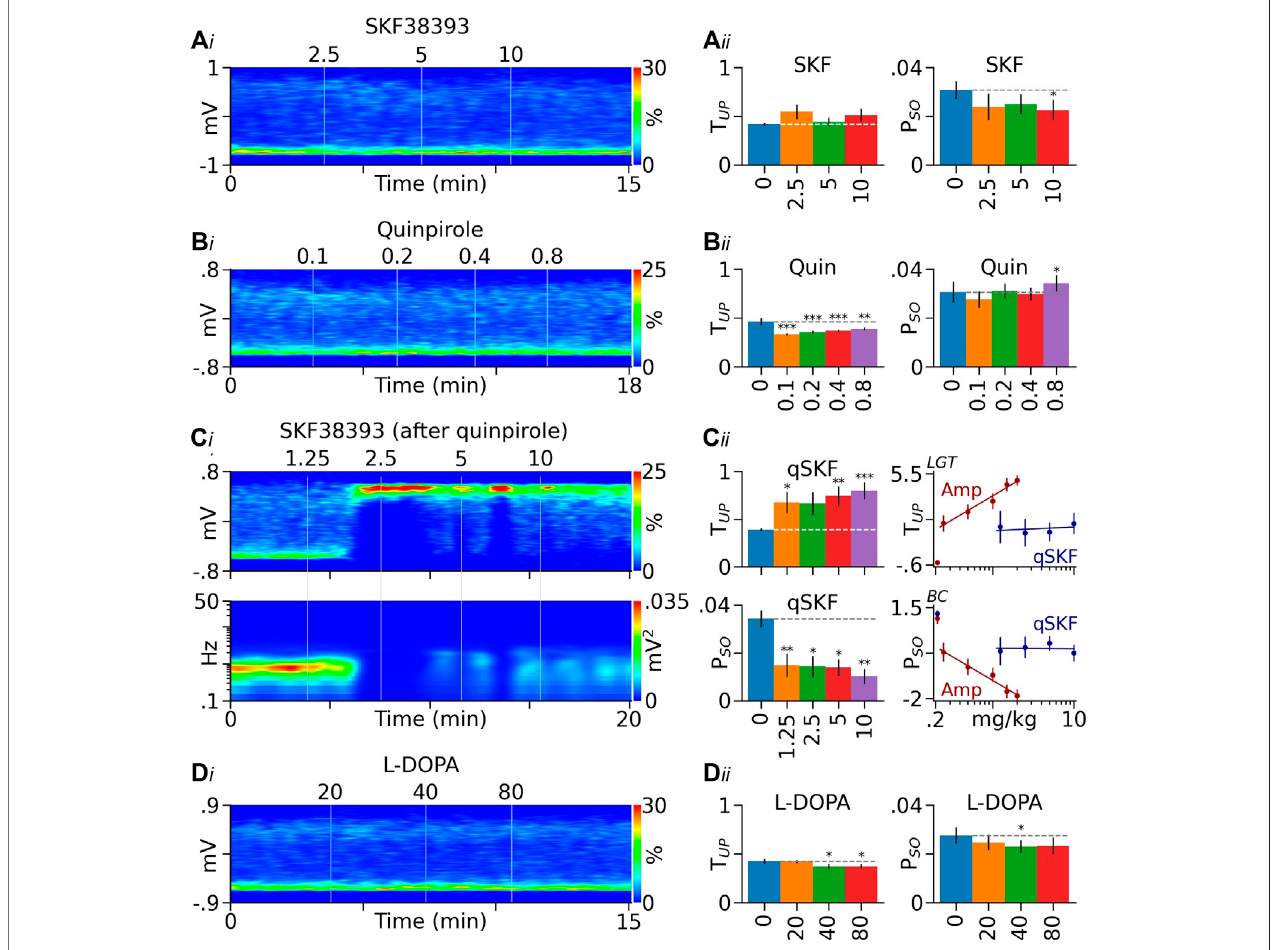
FIGURE 4 | Effects of DA receptor agonists and L-DOPA on PFC Up state. (Ai) Heatmap from a typical rat showing the lack of a signi fi cant effect of the D1-like receptor agonist SKF38393 (SKF) on PFC LFP distribution. (Aii) Summary graphs showing that SKF38393 produced no signi fi cant effect on T UP (left) and induced a smalldecrease in P SO (right). (Bi) Heatmap from another rat showing thatthe D2-like receptor agonist quinpirole (Quin) slightly shifted LFPs toward the Down state. (Bii) Summary graphs showing that thedecrease in T UP induced byquinpirole wassigni fi cant (left). Quinpirole also induced asmall increase in P SO (right). (Ci) Heatmap from a quinpirole-pretreated rat (0.8 mg/kg) showing that SKF38393 (qSKF) promoted the Up state (top) and suppressed the slow oscillation (bottom). (Cii) Summary graphs showing that in quinpirole-pretreated rats, SKF38393 signi fi cantly increased T UP and decreased P SO (left). Its dose-response curves are signi fi cantly right -shifted,however,relativetothoseof D -amphetamine(Amp,right).The y -axisvaluesindose-responsecurvesarelogit(LGT)orBox-Cox(BC)transformed. (Di) Heatmap from another rat showing that the DA/NE precursor L-DOPA slightly shifted PFC LFPs toward the Down state. (Dii) Summary bar graphs showing that the decrease in T UP induced by L-DOPA was signi fi cant (left). The drug also produced a small decrease in P SO (right). * p < 0.05, ** p < 0.01, *** p < 0.001 vs baseline (blue bars).